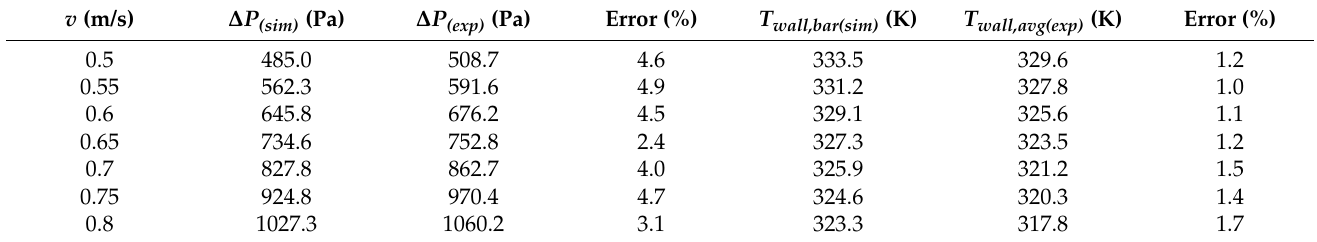
Table 7. Comparison of experimental and numerical simulation data at different flow velocities.